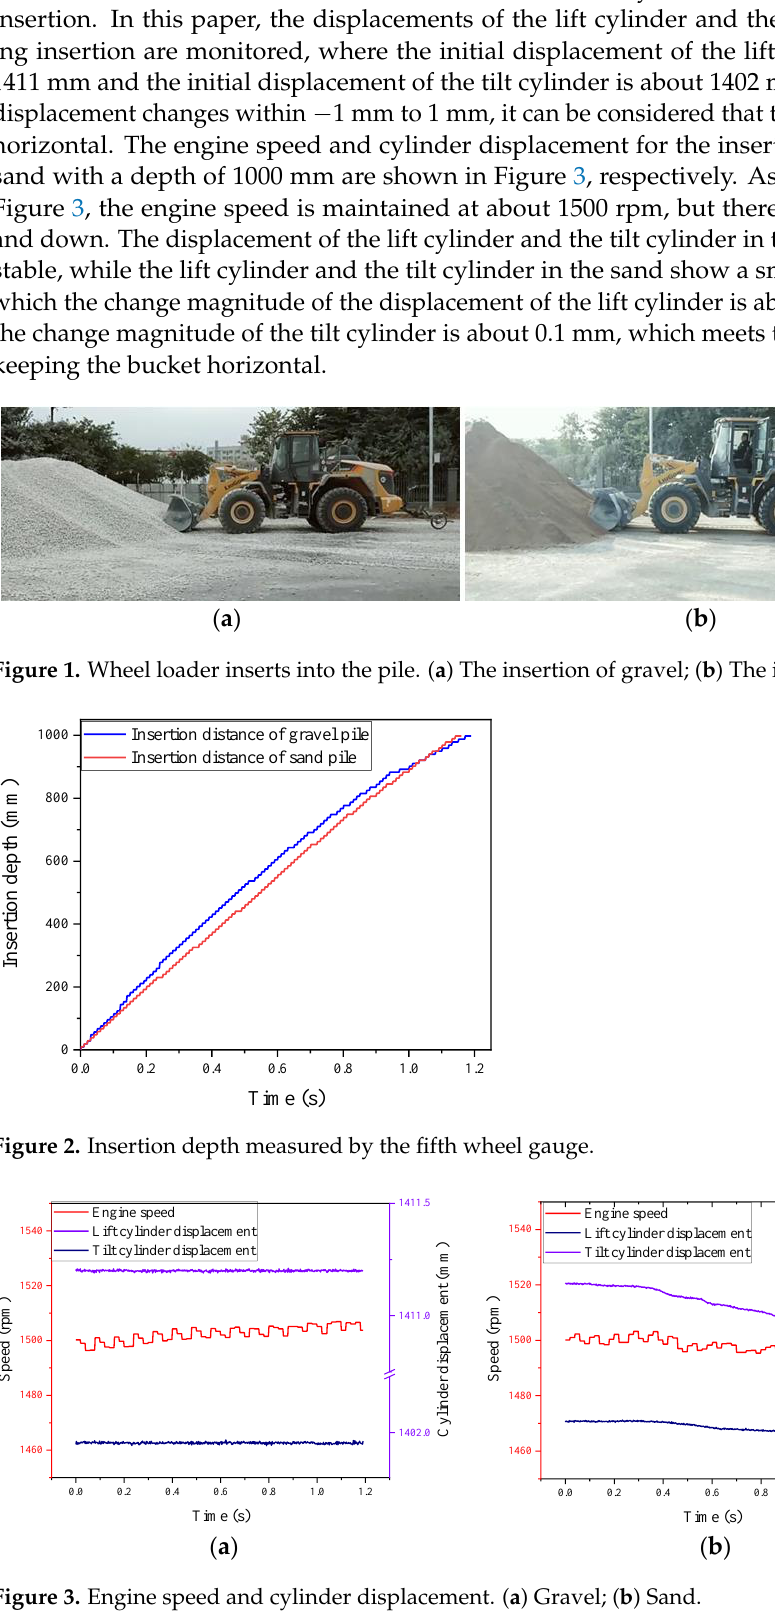
Figure 1. Wheel loader inserts into the pile. ( a ) The insertion of gravel; ( b ) The insertion of sand.